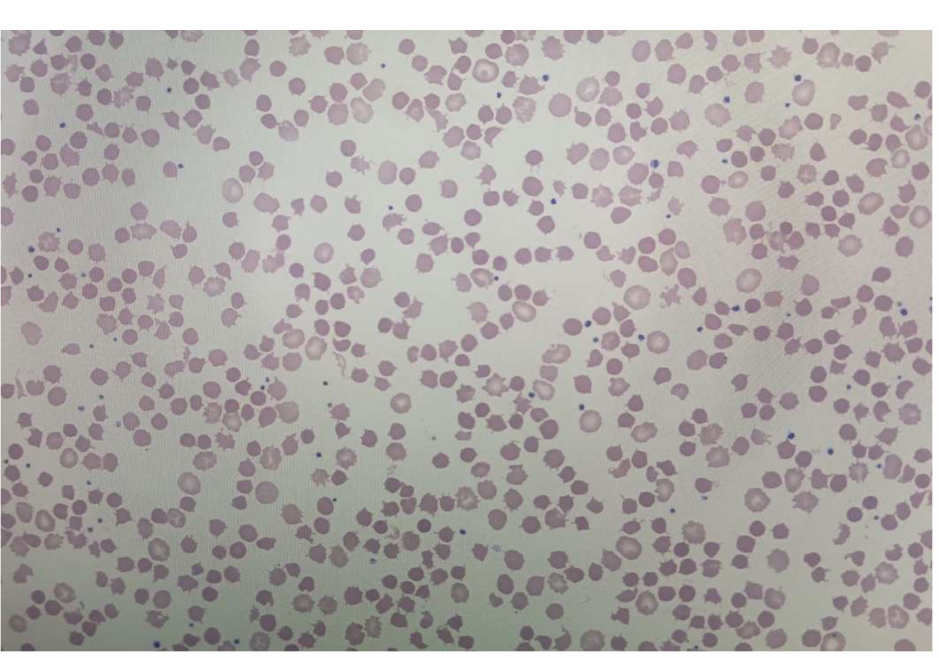
Figure 4. Peripheral Smear of patient 4 showing evidence of hemolytic anemia (presence of sphero- cytes, bite cells, echinocytes and